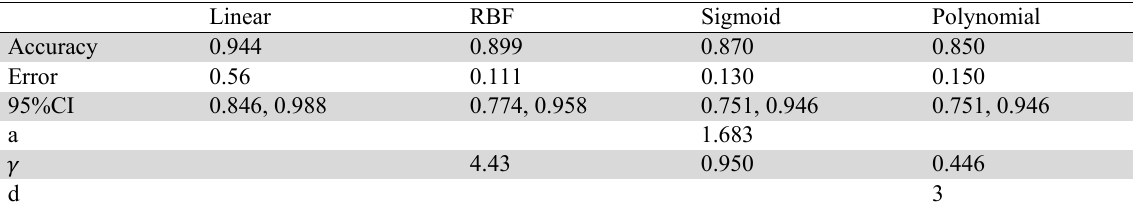
Performance criteria from 2007-2009